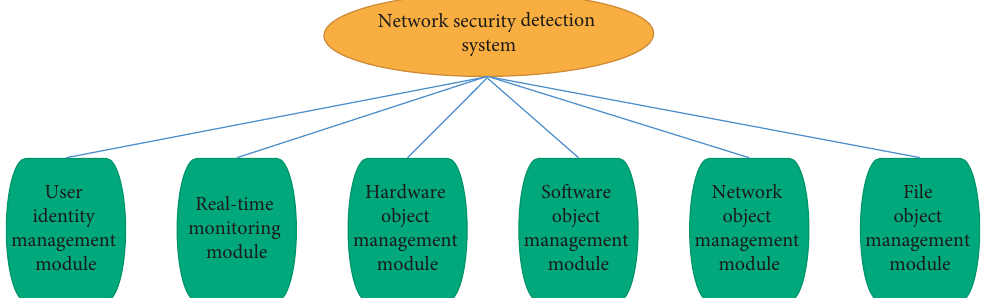
Figure 2: Overall functional structure of the